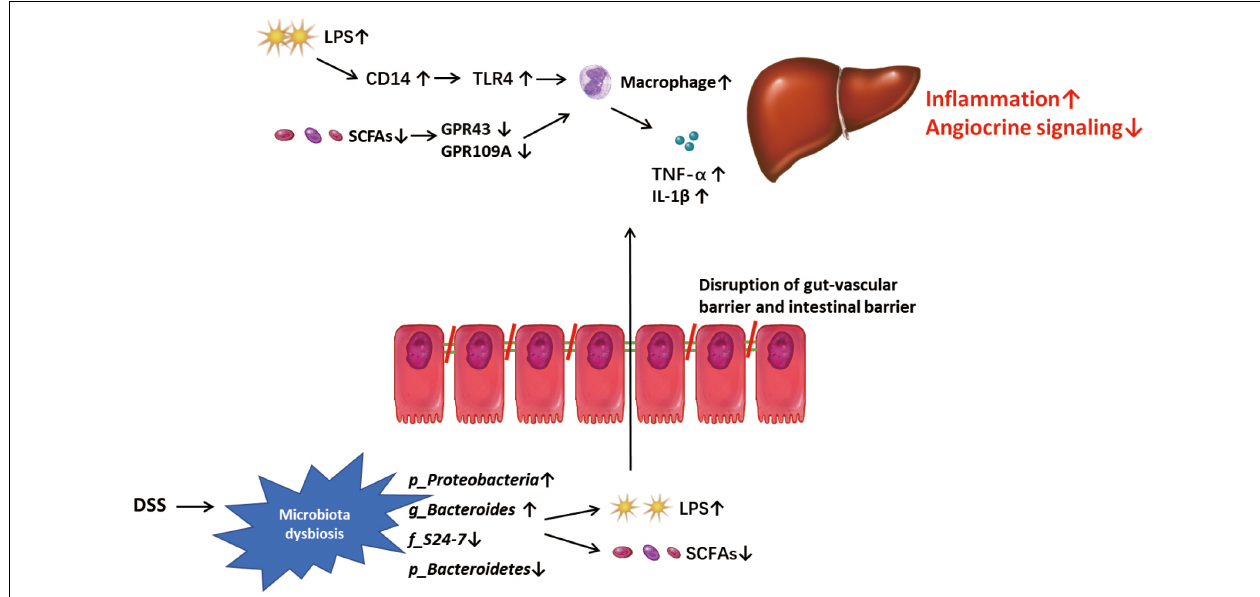
FIGURE 6 | Mode pattern. DSS-induced microbiota dysbiosis, especially the increased lipopolysaccharide (LPS)-pro-ducing microbiota and the decreased SCFAs-producing microbiota, might play a role in disrupting the gut-vascular barrier and inducing more LPS into liver, and promote the disease progression in liver through triggering macrophage-mediated inflammatory response and disrupting angiocrine